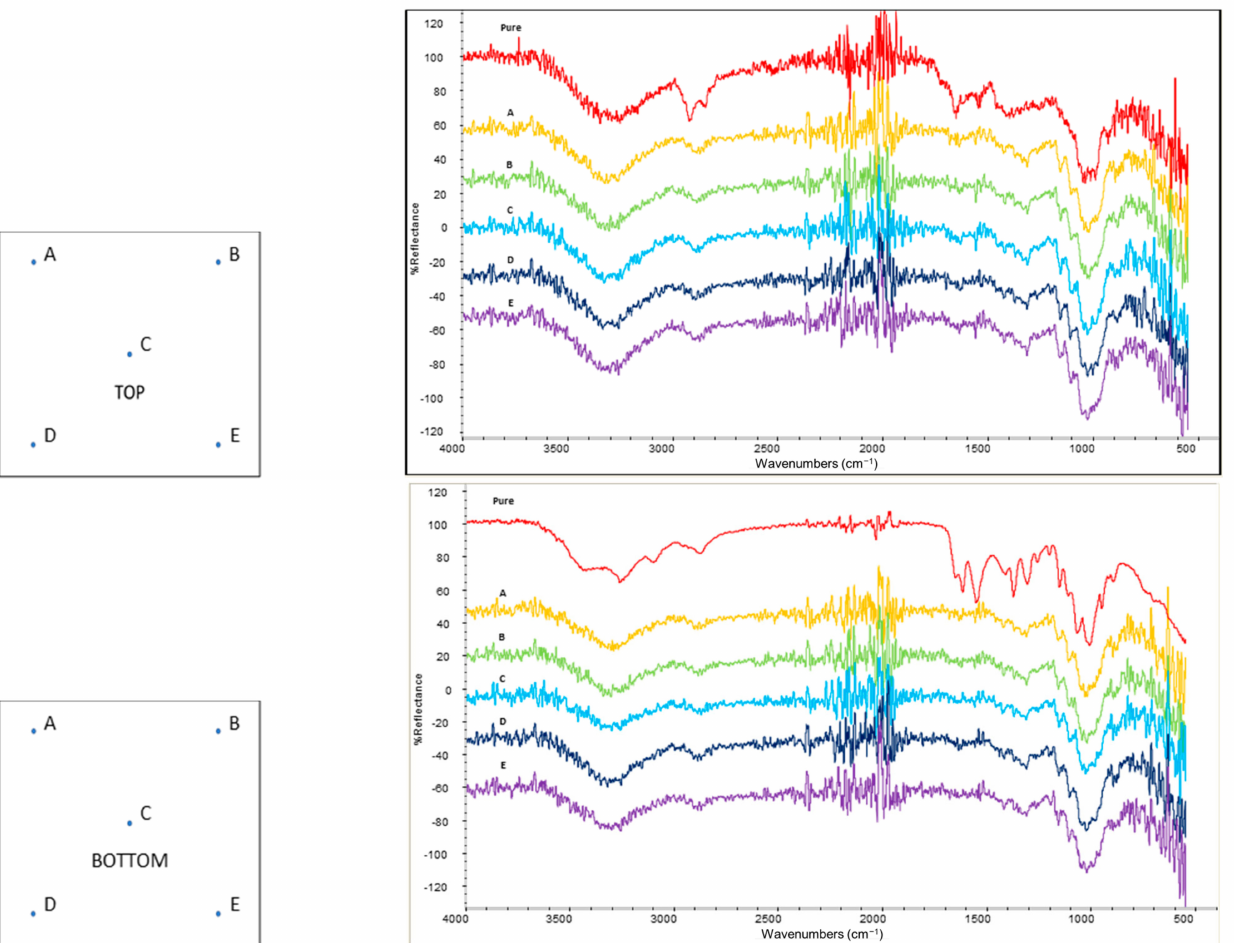
Figure 6. Spectra of the top and bottom part of chitin-treated tissues compared with IR spectrum of pure chitin (red). Capital letter on each spectrum indicate the point where it was acquired according to the relative picture on its